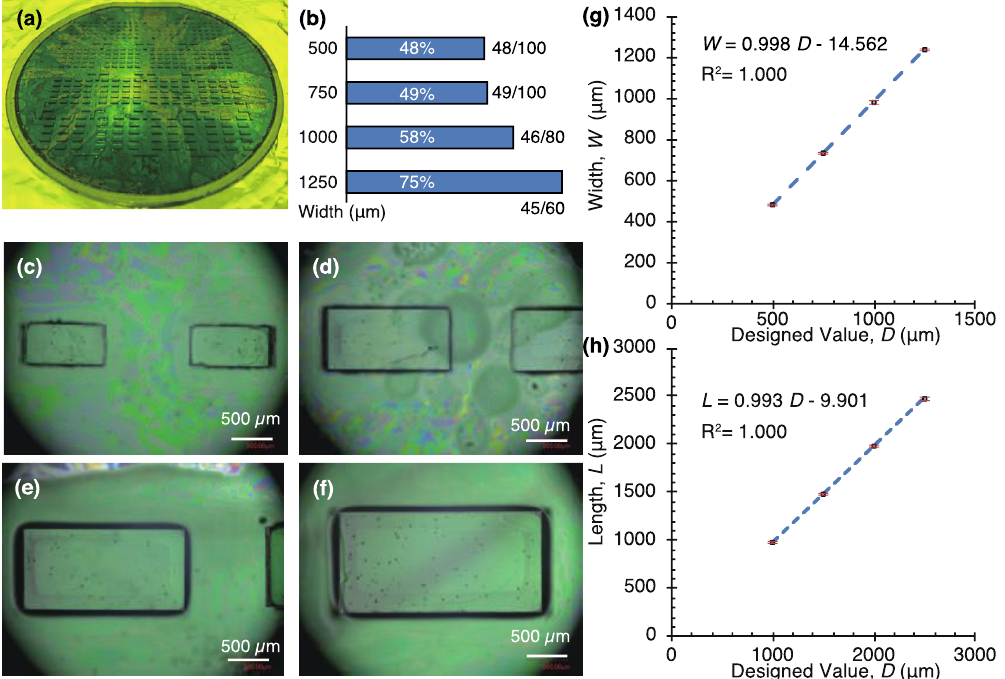
Figure 6. Fabrication of thick SU-8 molds for an open-top microchamber. Microscope image of channels with widths of ( a ) 714 μ m, ( b ) 969 μ m, ( c ) 1225 μ m, and ( d ) 1480 μ m. Scale bars: 1 mm. ( e ) Actual widths of SU-8 channels versus designed values.